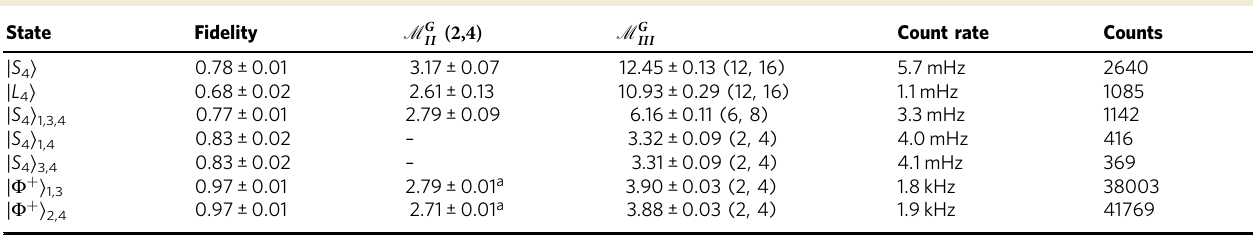
Table 1 Summary of measured parameters for on-chip graph states State